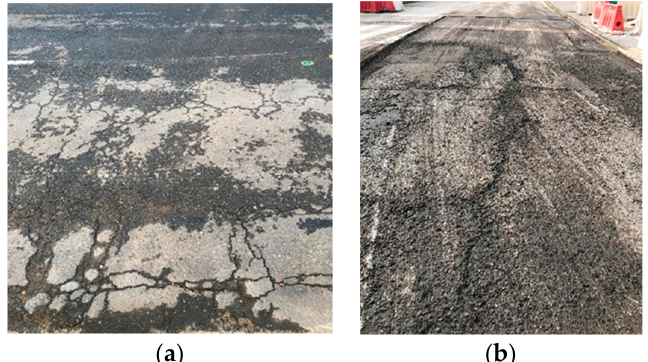
Figure 1. ( a ) Starting condition of a road in advanced degradation status. ( b ) Deep cracks in milled pavement.